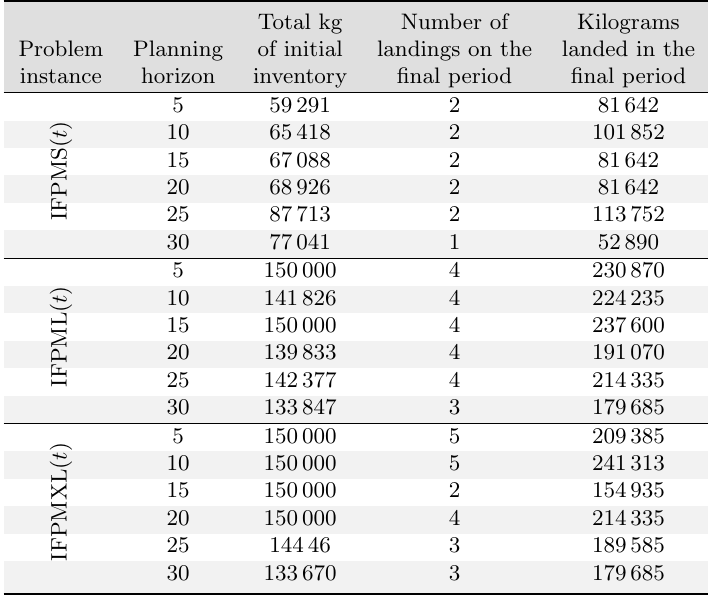
Table 5: Comparison of the total kg of raw materials landed in the final period for different total initial inventory levels for IFPMS ( t ) , IFPML ( t ) , and IFPMXL ( t ) . The total trawler capacities are 120 000, 240 000 and 360 000 for IFPMS, IFPML and IFPMXL,